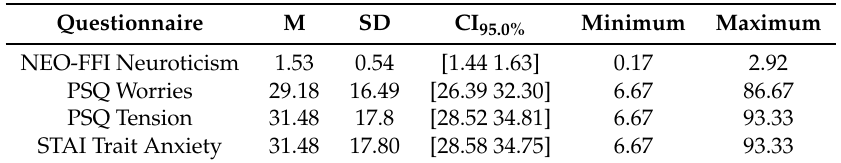
Table A1. Mean (M), standard deviation (SD), 95.0% confidence interval (CI 95.0% ), minimum, and maximum score of participants’ responses to Neuroticism (NEO-FFI), Worries and Tension (PSQ), and STAI Trait Anxiety (STAI-G-X2).